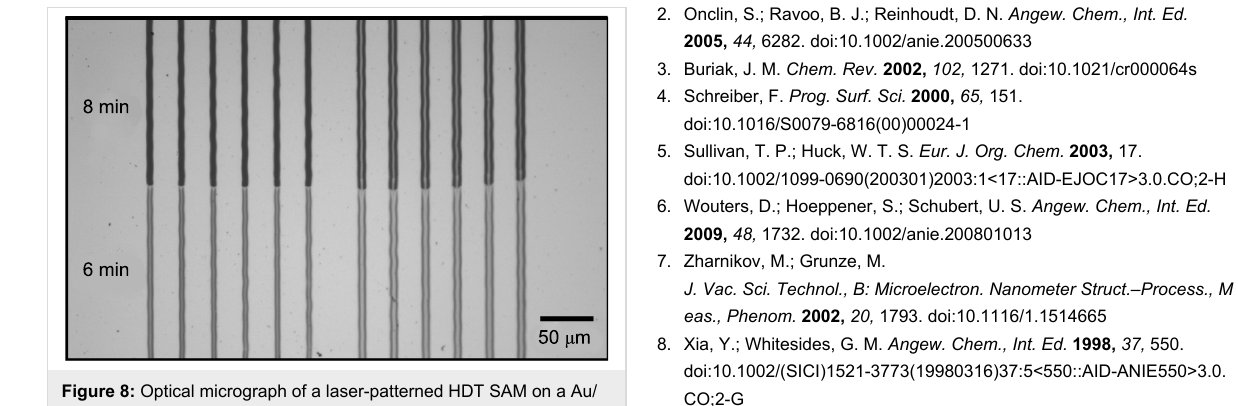
measurements were carried out at λ = 532 nm by using the